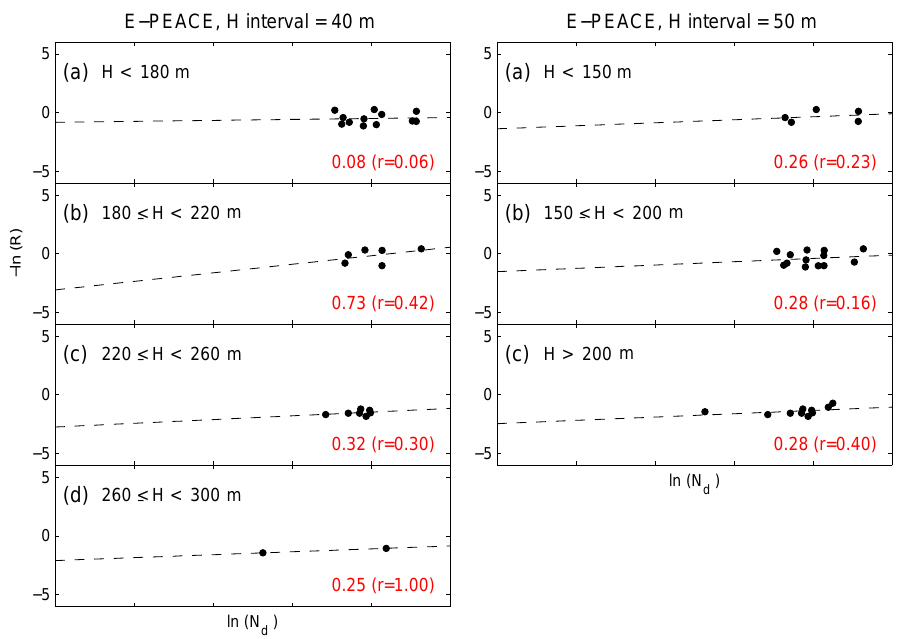
Figure C2. The ln ( N d ) and − ln ( R ) diagrams with fixed H intervals: (left) (cid:49)H = 40m, (right) (cid:49)H = 50m.